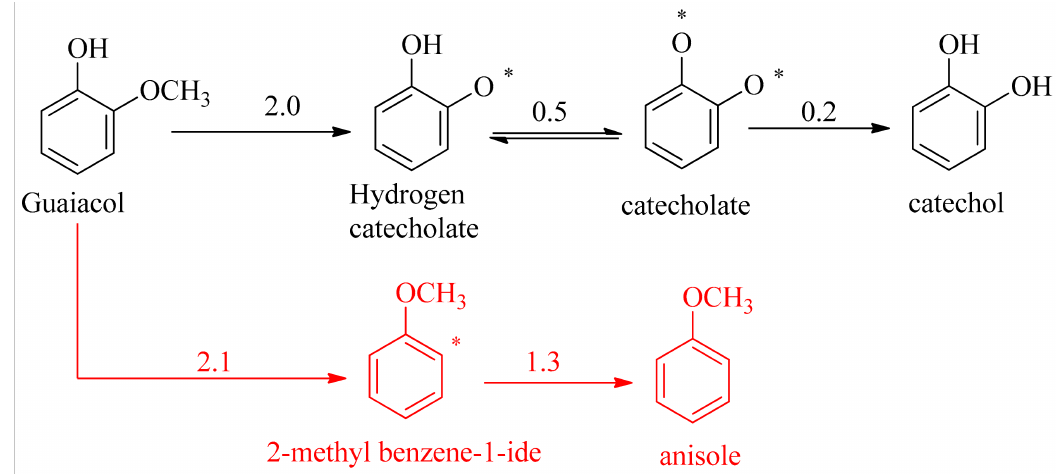
Figure 8. Overall proposed reaction steps for the conversion of guaiacol to catechol and anisole on Cu (111). Numerical values over the arrows denote activation energies for individual elementary steps in eV. * indicates on the adsorbate, the sites of decomposition and radical